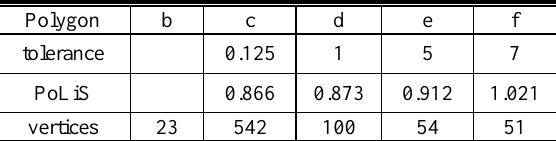
Table 4. Example polygon with different tolerance and number of vertices. The columns b, c, d, e, f correspond to the polygons